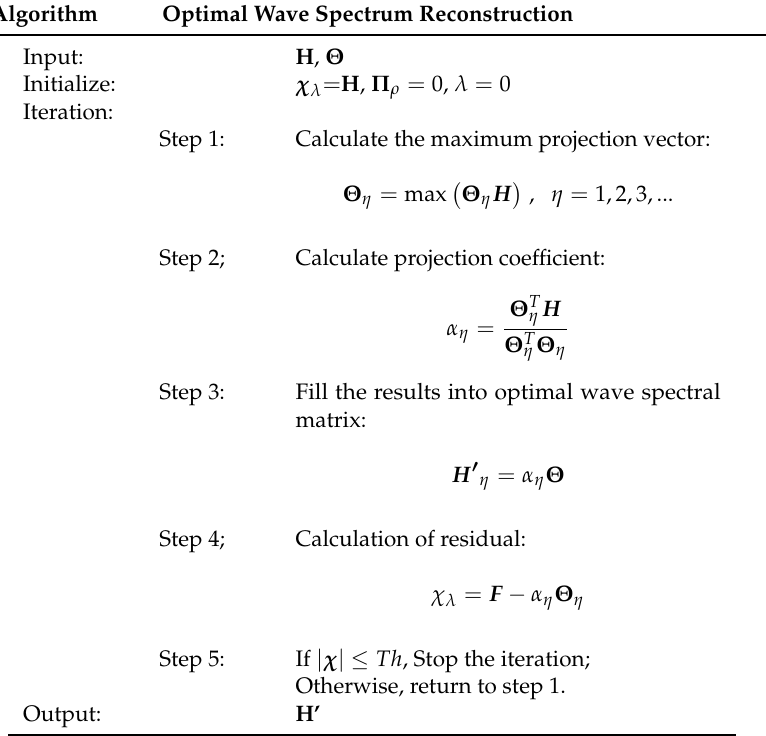
Algorithm Optimal Wave Spectrum